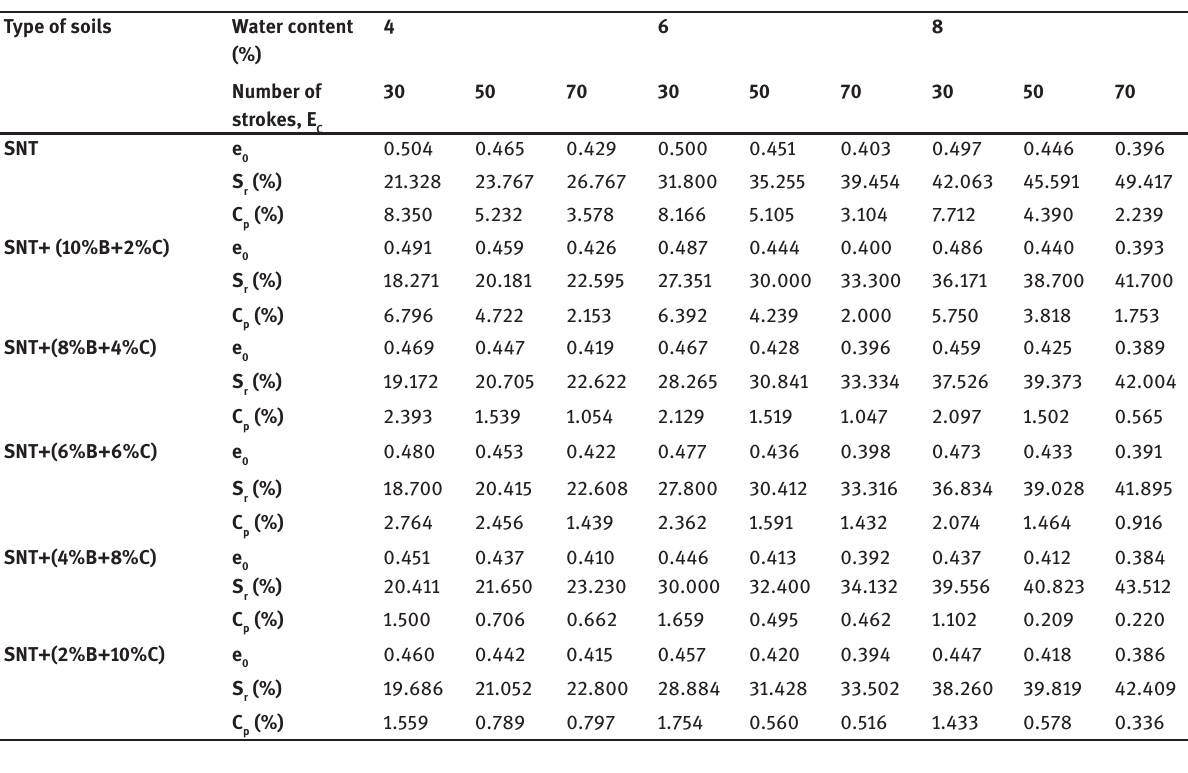
of the treated and untreated soils. p